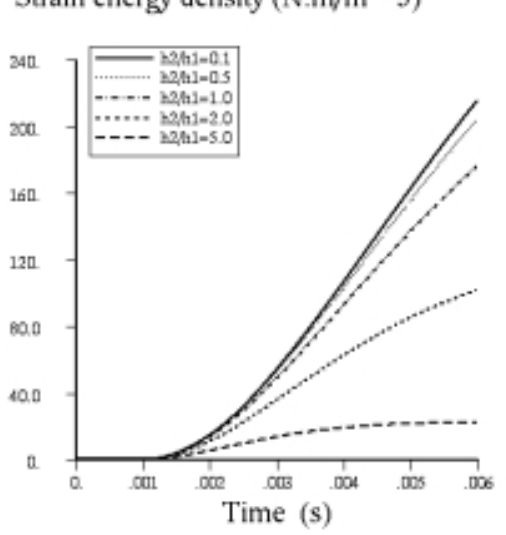
Fig. 7. Variation of central velocity with charge weight for different thickness